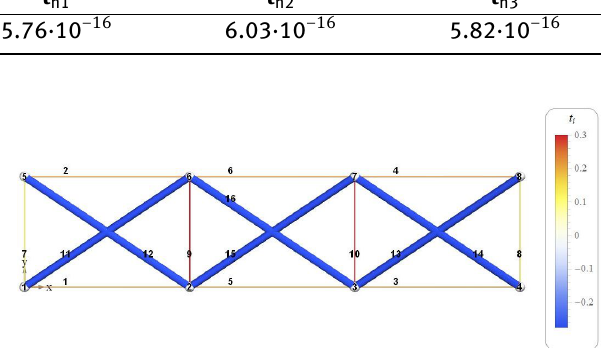
Figure 5: Snelson’s X beam with three modules, perspective